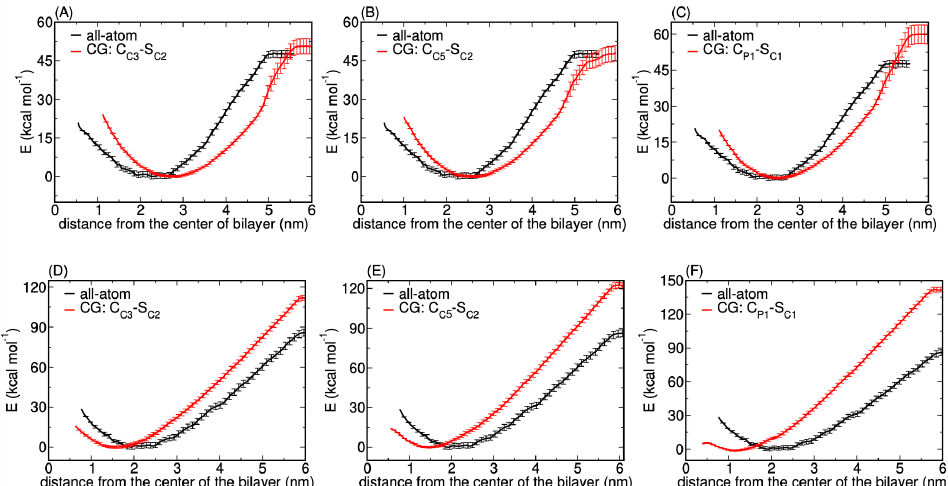
Figure 6. PMFs (red curves) calculated for the insertion of a CG NP of size 3 nm (top) and 5 nm (bottom) in the lipid bilayer composed of DPPC, POPC, DOPC and CHOL in a 5:2:2:1 ratio. The core-shell representation of the NP was considered. Subplots ( A – F ) correspond to the different CG bead combinations used to define the shell and the core of the NP. The shaded region corresponds to the standard deviation calculated over 100 iteration steps using the bootstrapping technique in GROMACS. The reference PMFs (black curves) were determined using constrained AAMD for the considered NP sizes in our previous atomistic study [35], and are only added here to enable a direct visual